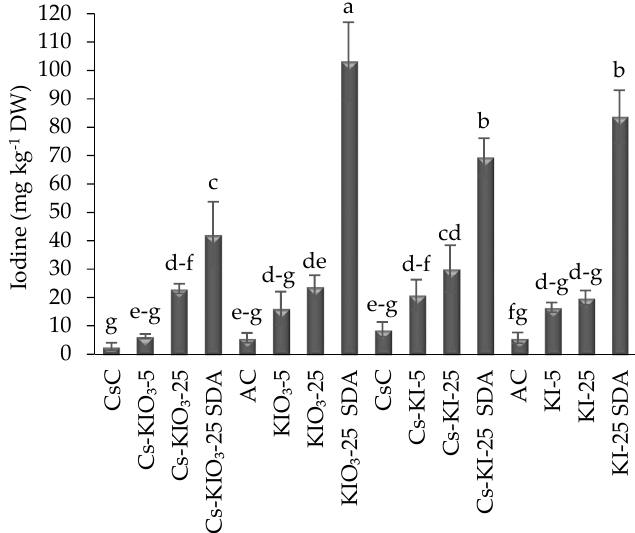
Figure 1. Iodine concentrations in mixed samples of lettuce leaves and heads following iodine salt treatments with and without chitosan. Means with the same letter are statistically identical (LSD, p ≤ 0.05); the bars represent the standard error (n = 6).